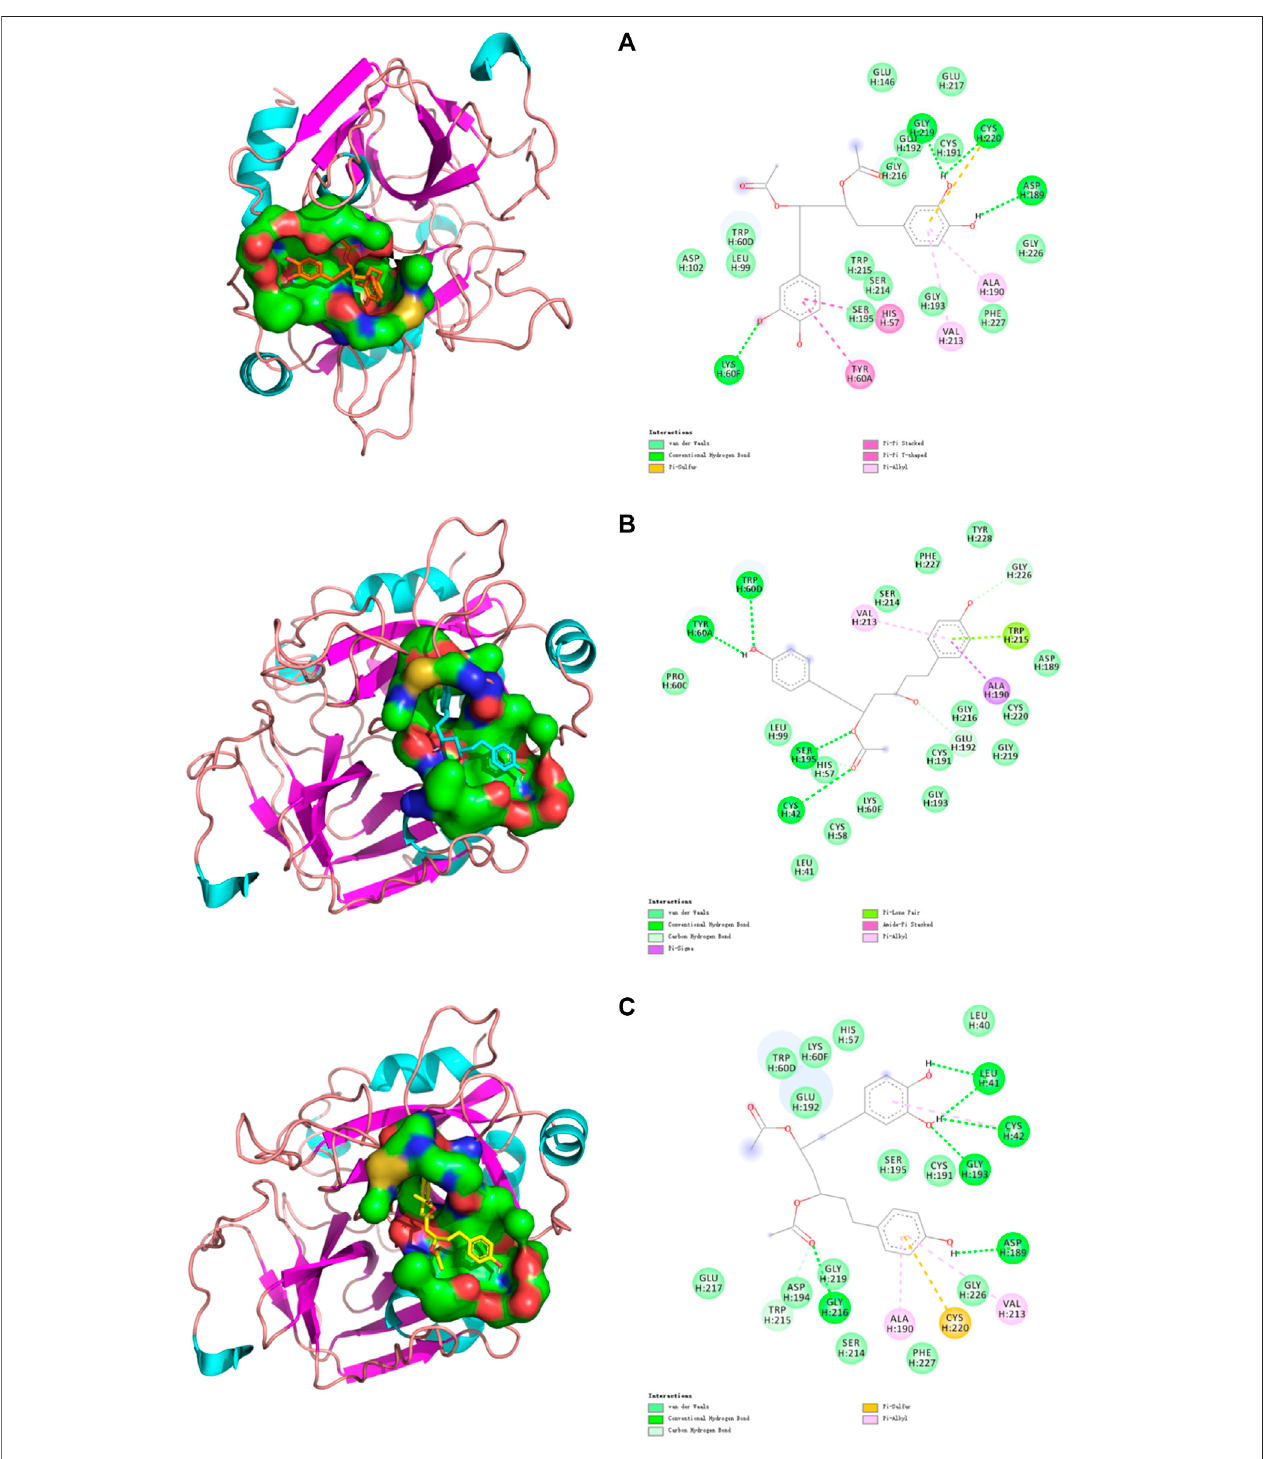
FIGURE5| Dockingmodelsof (A) C7, (B) C8,and (C) C11inTHRactivesite.(VanderWaalsarecoloredinlightgreen;Hydrogenbondsarecoloredindeepgreen; Yellow, purple, deep pink, and light pink indicate hydrophobic interactions and represent Pi-Sulful, Pi-sigma, Amide-Pi Stacked, and Pi-Alkyl, respectively).